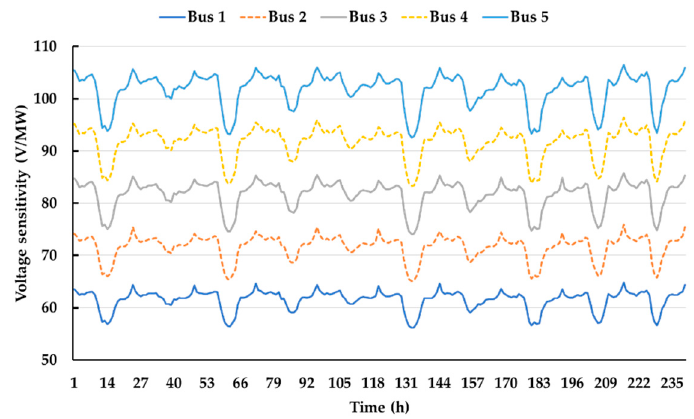
Figure 4. Voltage sensitivity to the end of the feeder for each bus.